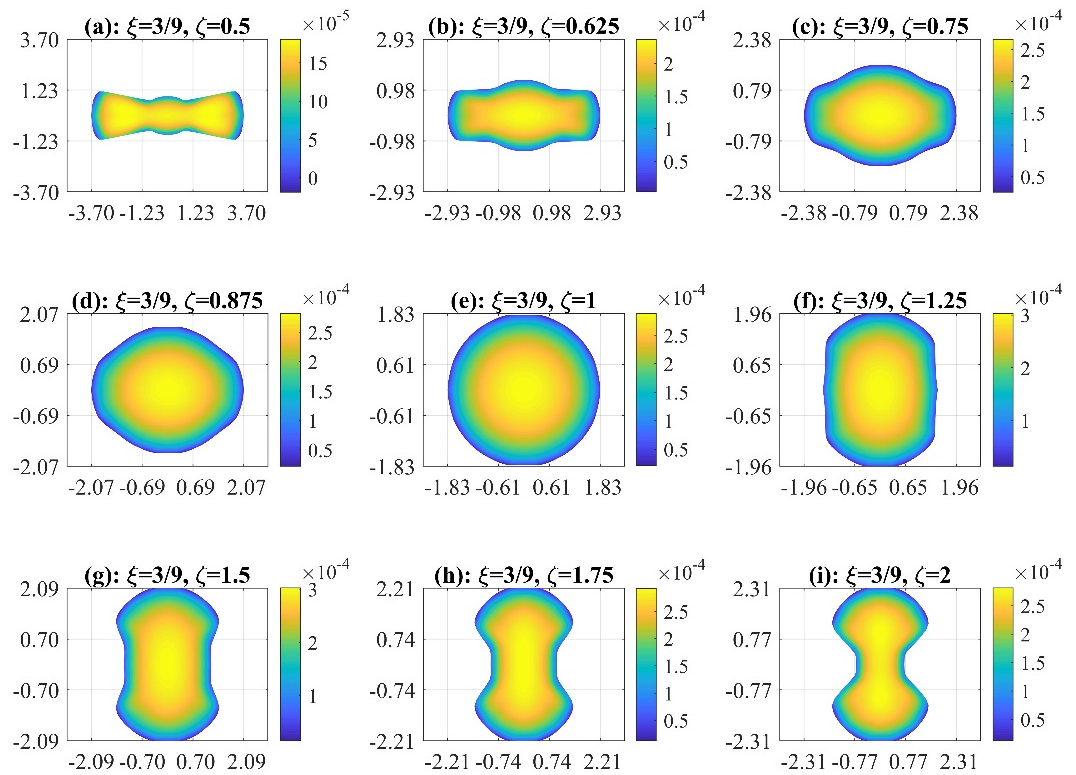
Figure 11. Distributions of fracture opening of Group 2 numerical experiments ( ξ = 3/9) with 9 different fracture toughness contrasts at the moment = 20 s .